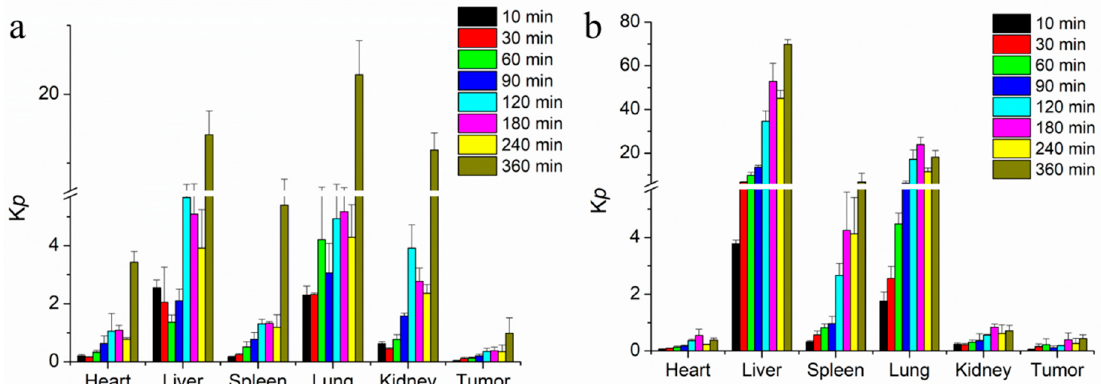
Figure 14. Ratio of tissue to plasma concentrations ( K p) at different times following via the tail vein dose (25 mg/kg) of Duopafei ® ( a ) and DTX-loaded BSPs-SA nanoparticles ( b ). Data are shown as mean ± SD. ( n = 5).